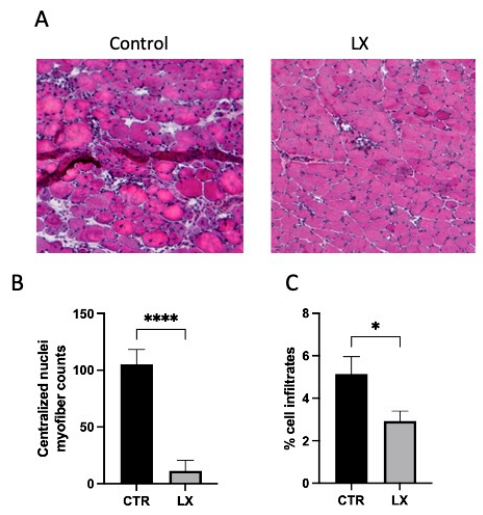
Figure 5. Perinatal SPL inhibition reduces pathological signs of muscle injury. ( A ) Representative hematoxylin and eosin stained cryosections of skeletal muscles ( tibialis anterior ) isolated from LX2931-treated (LX) and control (CTR) mdx pups showing muscle damage is reduced in treated pups. ( B ) Quantification of myofibers containing centralized nuclei. ( C ) Quantification as percentage of cell infiltrates. Shown are mean ± SEM; * p < 0.05, **** p < 0.001; n = 8–11/group.